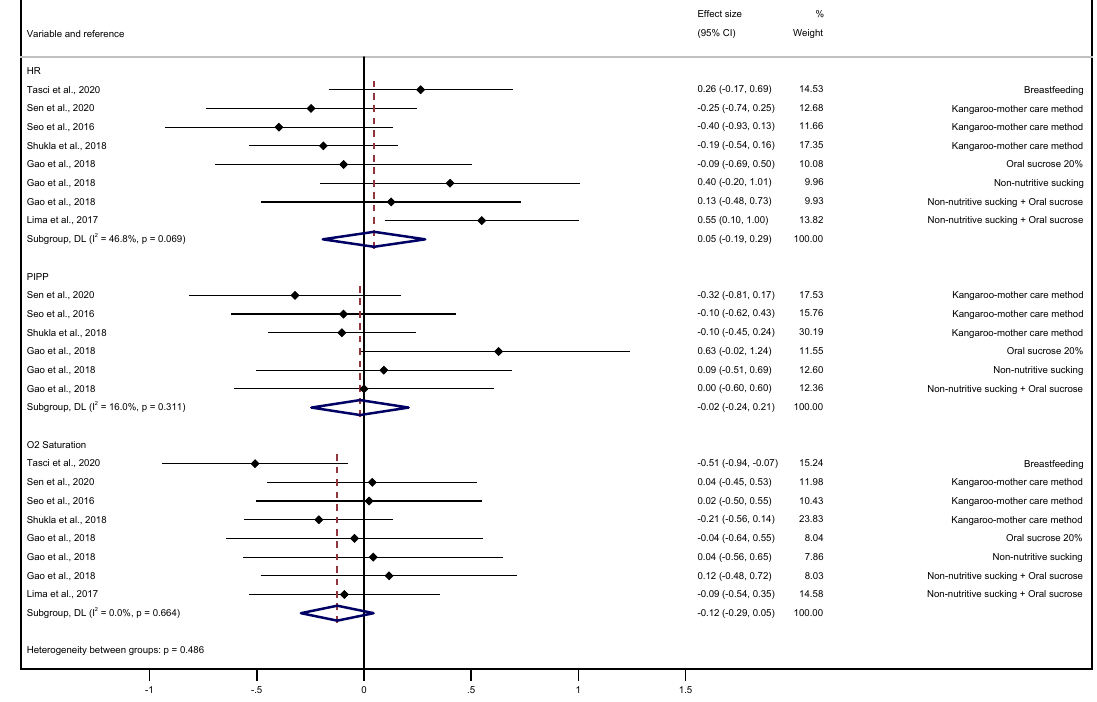
Figure 5. Forest plot for the pooled effect size of interventions for neonatal pain variables (HR, PIPP scale and O 2 saturation).